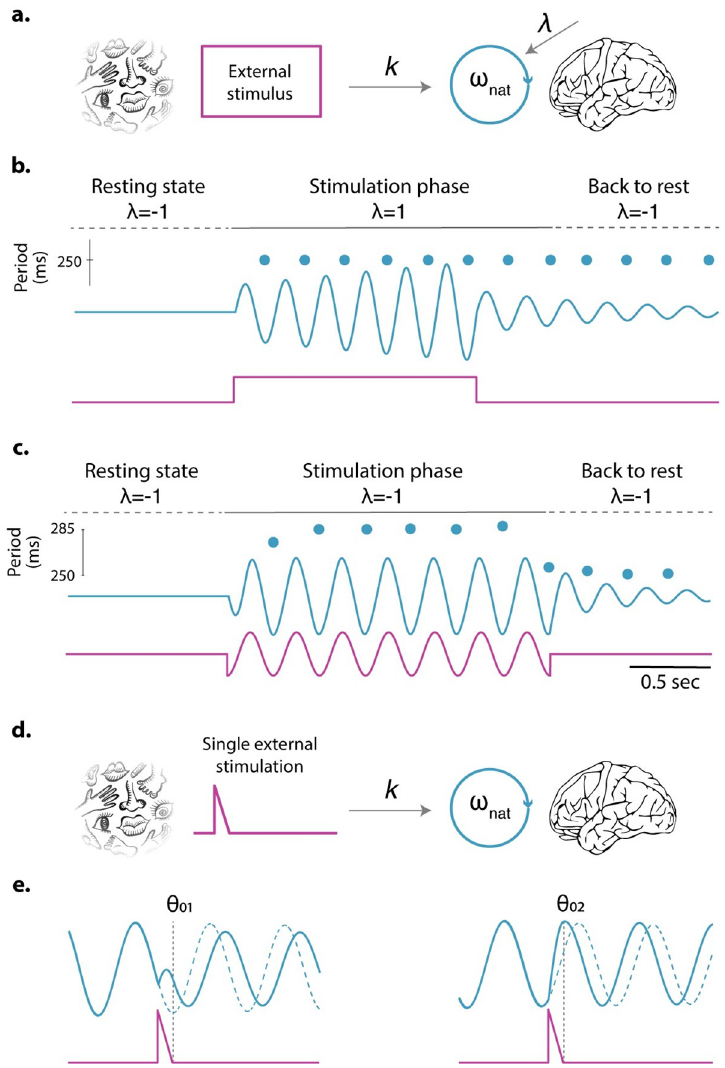
Fig 2. Simulations for different interactions of the neural oscillator with an external stimulus. (a) Schematic representation of the model used to run the simulations shown in panels b and c : The neural oscillator is driven top- down and/or bottom-up by an external stimulus. The model assumes the same bottom-up interaction as in Fig 1, but this time, it can be modulated by a top-down mechanism. Mathematically, it implies that λ is shifted by the presence of an external input. (b) The oscillator receives a constant external input, and λ is top-down modified by the onset of the stimulus. Simulation parameters are ω nat = 2 π 4, γ = 1, k = 50, and s(t) a step function switching from 0 to 1. (c) The oscillator is only bottom-up driven by a rhythmic stimulation. Simulation parameters are ω nat = 2 π 4, γ = 1, k = 25, and s(t) a sinusoid is a sinusoid with a frequency fixed at 3.5 Hz. (d) Schematic representation of the model used to run the simulations shown in panel e : The neural oscillator is driven bottom-up by a single event. (e) Oscillator’s response when forced by a single stimulus. Once the external perturbation ceases, the oscillator resumes its natural ongoing activity but with a phase lag. The same stimulus resets the ongoing oscillation to different values ( θ 01 , θ 02 ) depending on the initial phase. Dashed lines: unperturbed oscillator’s activity. Simulation parameters are ω = 2 π 4, γ = 0.1, and nat k = 50. Blue traces: oscillator’s response, i.e., x(t). Magenta traces: external stimulus, i.e., s(t). Blue dots: time evolution of the oscillator’s period.